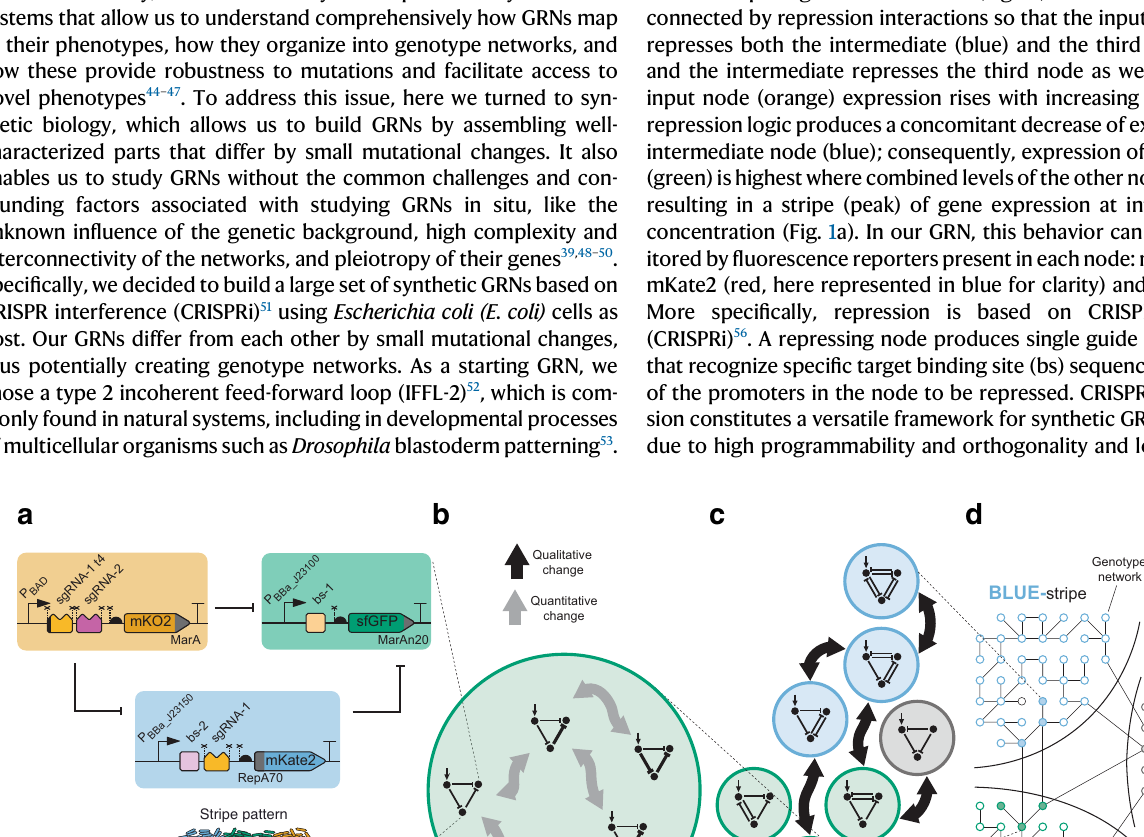
Fig. 1 | Overview of three interlinked genotype networks of synthetic GRNs built in this study that produce distinct phenotypes for stripe formation: BLUE-stripe, GREEN-stripe, and non-functional. The different levels of organi- zationaredepicted. a DetailsofthemolecularimplementationofoneGRN(GRN1.1 from Fig. 2), with the resulting GREEN-stripe phenotype schematically depicted below. Key to symbols: Bent arrows: promoters; squares: sgRNA binding sites; jagged rectangles: sgRNAs; crosses: Csy4 recognition sites; semicircles: ribosome binding sites (RBSs); pointed rectangles: reporter genes; and T-s: transcriptional terminators. MarA, MarAn20 and RepA70 denote orthogonal degradation tags.